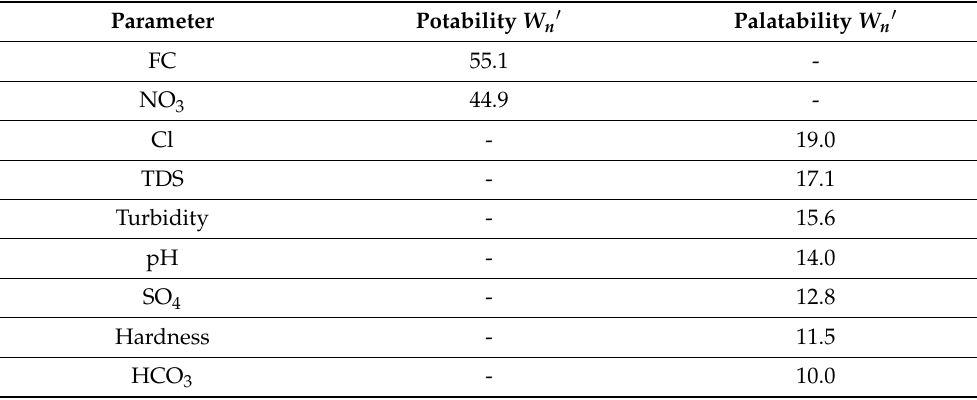
Table 4. Groundwater potability and palatability weighting systems in the West Bank.